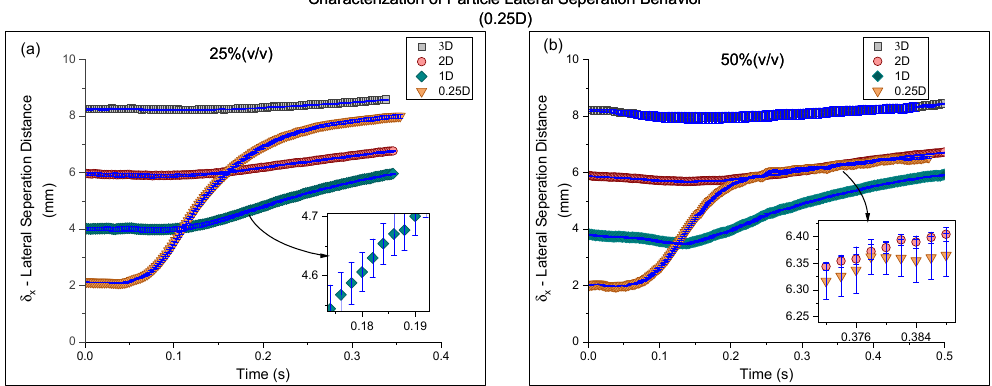
Figure 6. Plots representing particle lateral separation distance ( δ x ) as a function of time for prominent repulsion ( v/v ) mixtures of glycerin and water, ( a ) 25% and ( b ) 50%, at various initial separation distances ( δ 0 ) —3D, 2D, 1D, and 0.25D. The plots indicate an inverse relationship between initial separation distance and lateral separation distance.